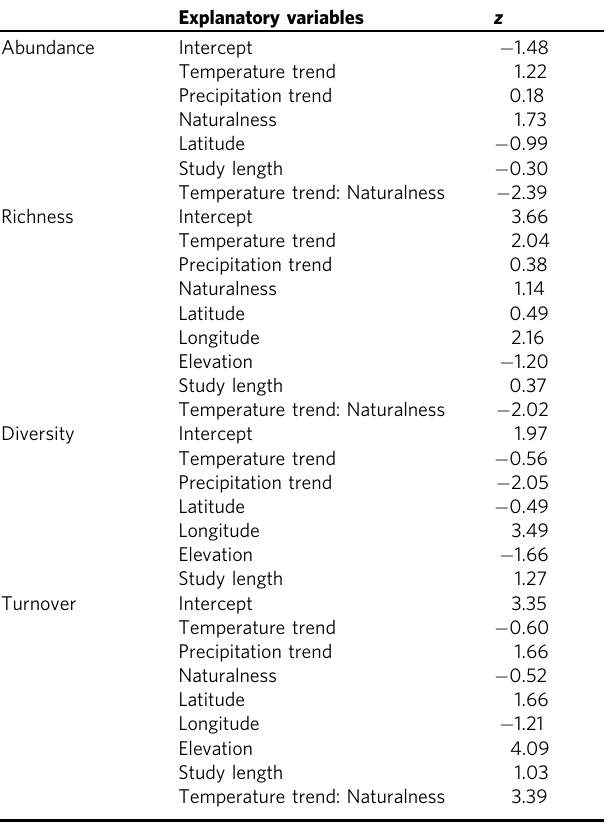
Table 2 In fl uence of climatic trends and site characteristics on biodiversity